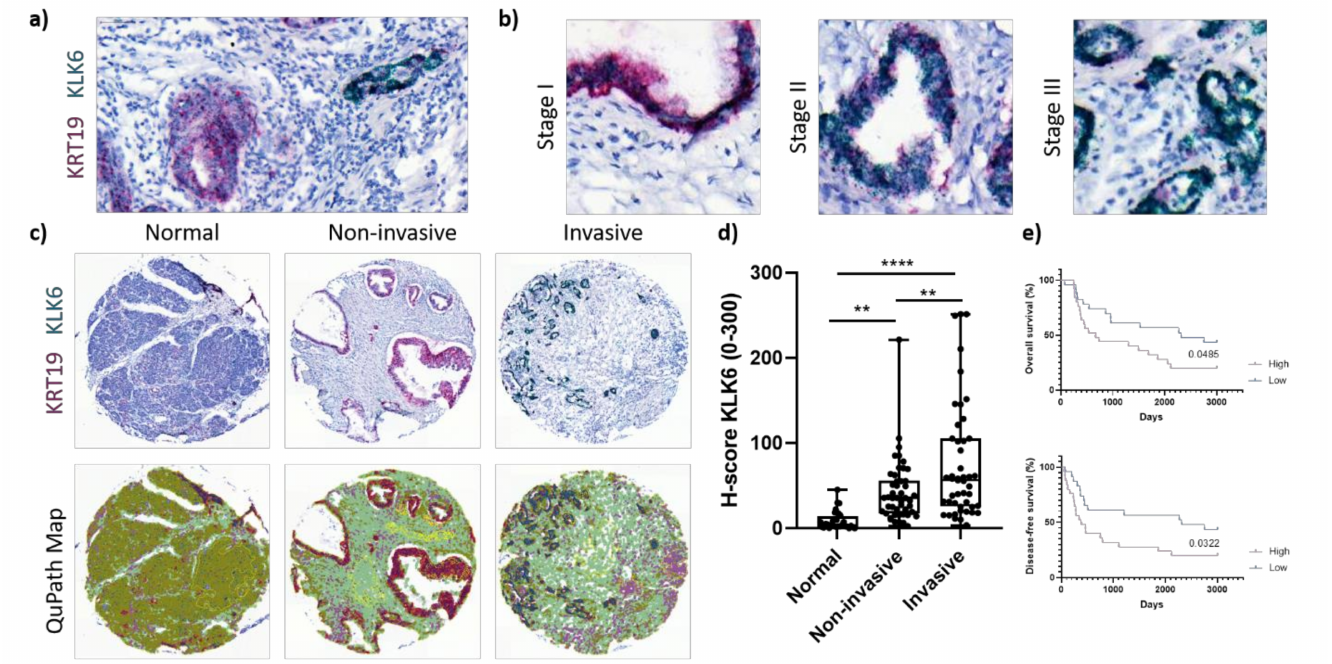
Figure 2. KLK6 mRNA expression in PDAC tissues. ( a ) Representative image of dual in situ hybridisation of KLK6 (green) and KRT19 (red) in PDAC tissues, indicative of a high copy number of both mRNAs. ( b ) Representative images of dual in situ hybridisation of KLK6 (green) and KRT19 (red) depict high copy numbers of KLK6 independent of tumour stage. ( c ) Representative images of dual in situ hybridisation of KLK6 (green) and KRT19 (red) in normal pancreas and PDAC tissues and the respective QuPath map images below. ( d ) KLK6 mRNA was upregulated in PDAC compared to normal pancreas tissues, with invasive tumour areas having higher mRNA levels compared to the noninvasive counterparts. ( e ) Kaplan–Meier analysis indicated that high KLK6 expression levels were significantly associated with shorter overall ( p = 0.0485) and disease-free ( p = 0.0322) survival than low expression levels (H-score cut-off 55). Asterisks indicate statistical significance (** p ≤ 0.01 and **** p ≤